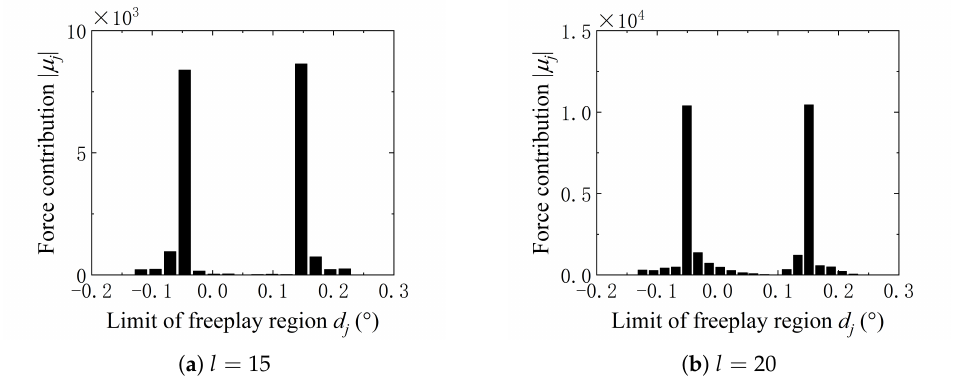
Figure 13. The identification of offset freeplay using the 1st displacement range [ min ( q r ) ,max ( q r )]